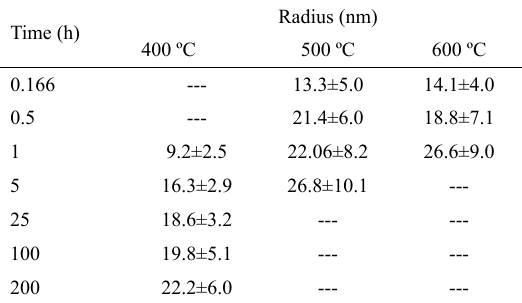
Table 1. Variation of precipitate equivalent radius with time for aging at 400, 500 and 600 ºC Time (h)